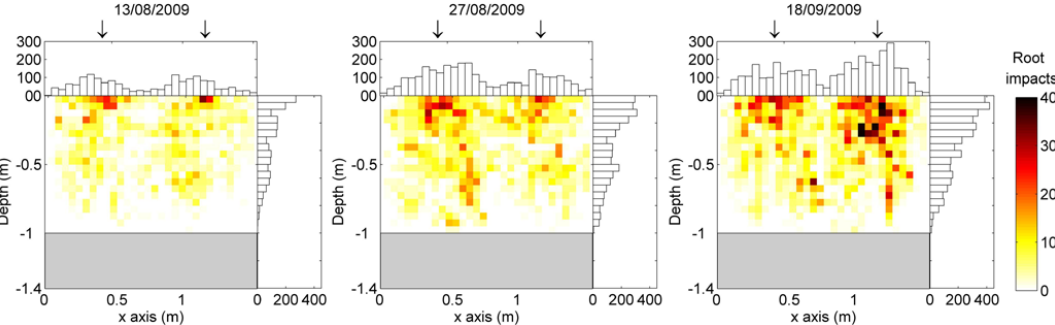
Fig. 13. Root profiles obtained by Tardieu’s method. The coloured squares correspond to the number of root impacts, resulting in a 2-D distribution of roots. The colour scale represents the number of root impacts. The horizontal and vertical histograms correspond to the number of root impacts in the x and y-directions, respectively. It helps to compare the number of impacts in the row and inter-row areas and for the different depths. The grey area delimited the zone without measurements. The arrows indicate the maize rows position.